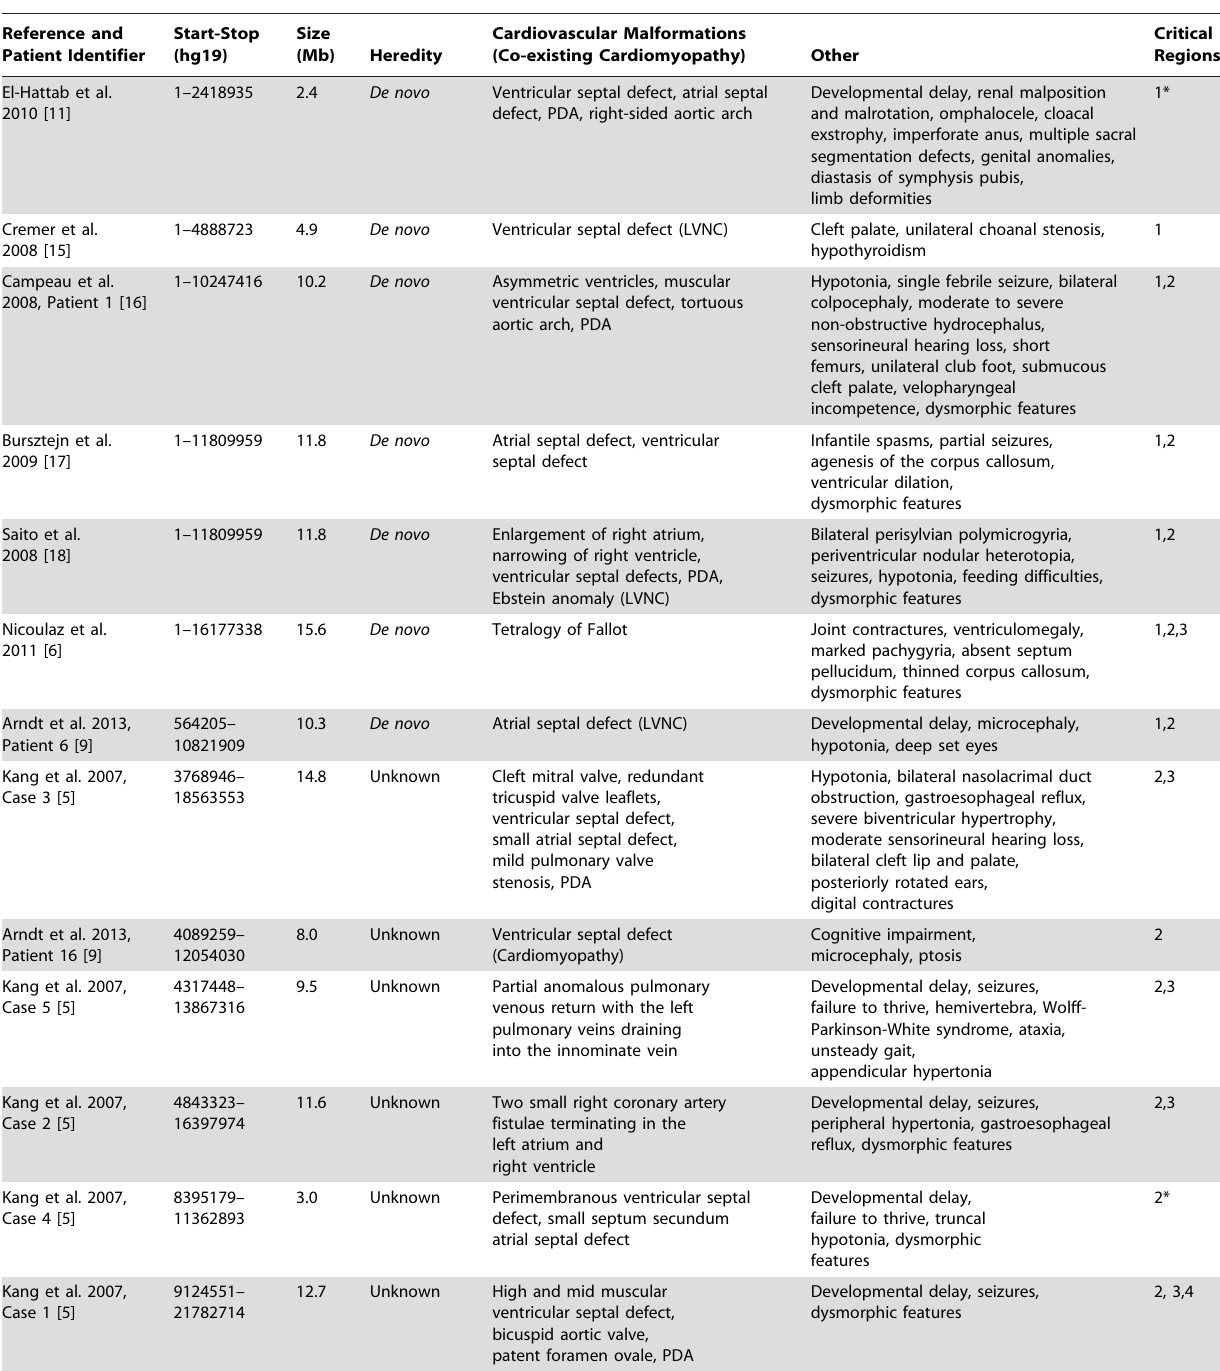
Table 3. Summary of individuals with isolated 1p36 deletions and cardiovascular malformations identified from the